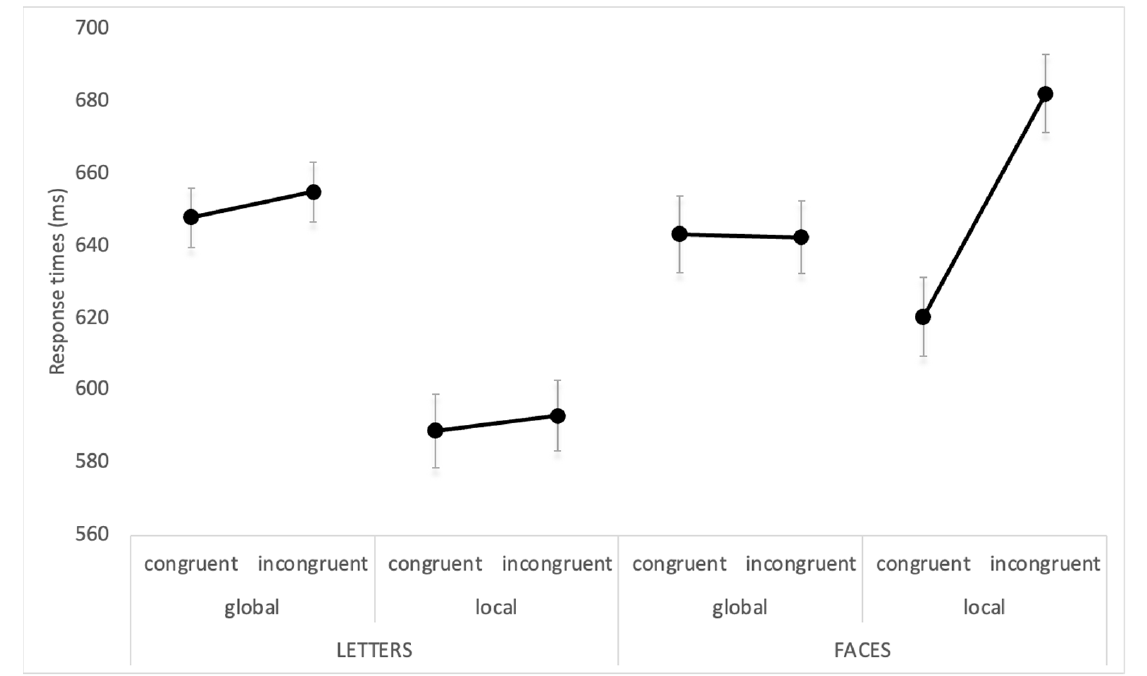
Figure 3. Average reaction times expressed in ms for letters and faces in the different experimental conditions and tasks (Experiments 1a and 1b). Bars represent standard errors.